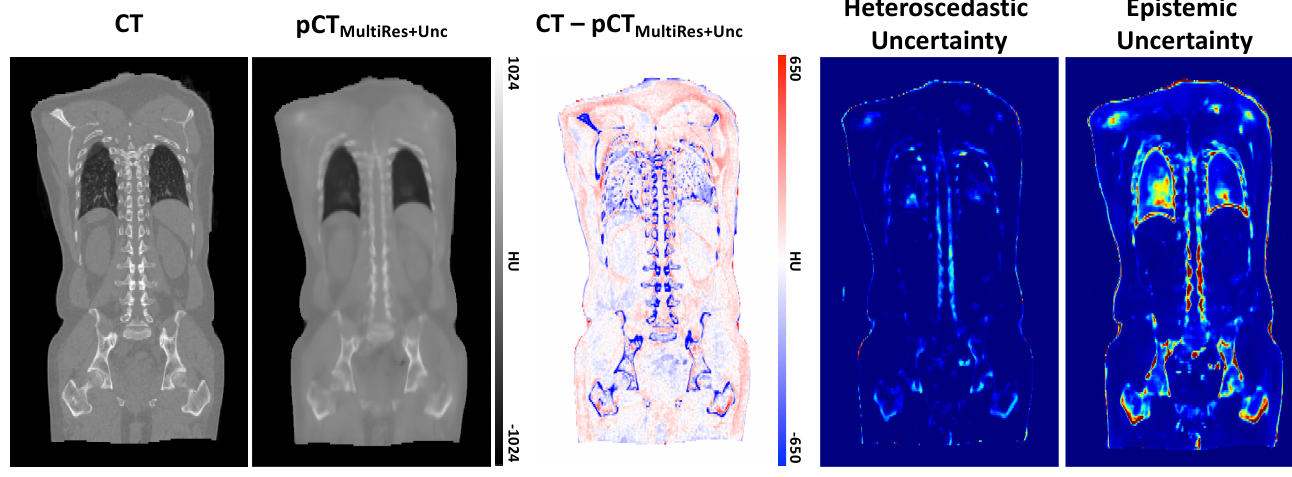
Figure 3. From left to right: Whole-body CT ground truth, pseudo CT prediction of MultiRes unc , corresponding residuals, heteroscedastic uncertainty and epistemic uncertainty. Both uncertainties correlate with the residual error map.